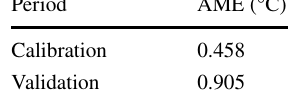
two calibration and validation periods for temperature